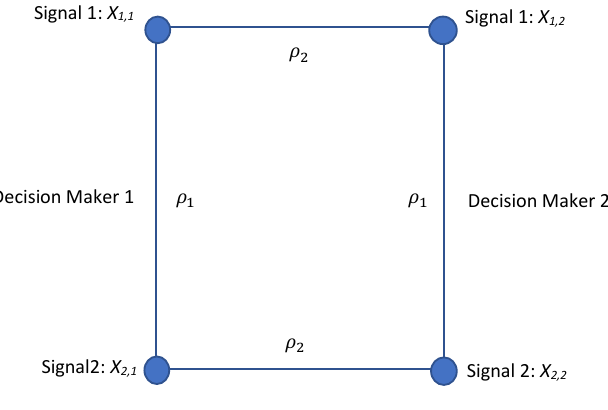
Figure 1. Structure of the correlations between the signals observed by the decision